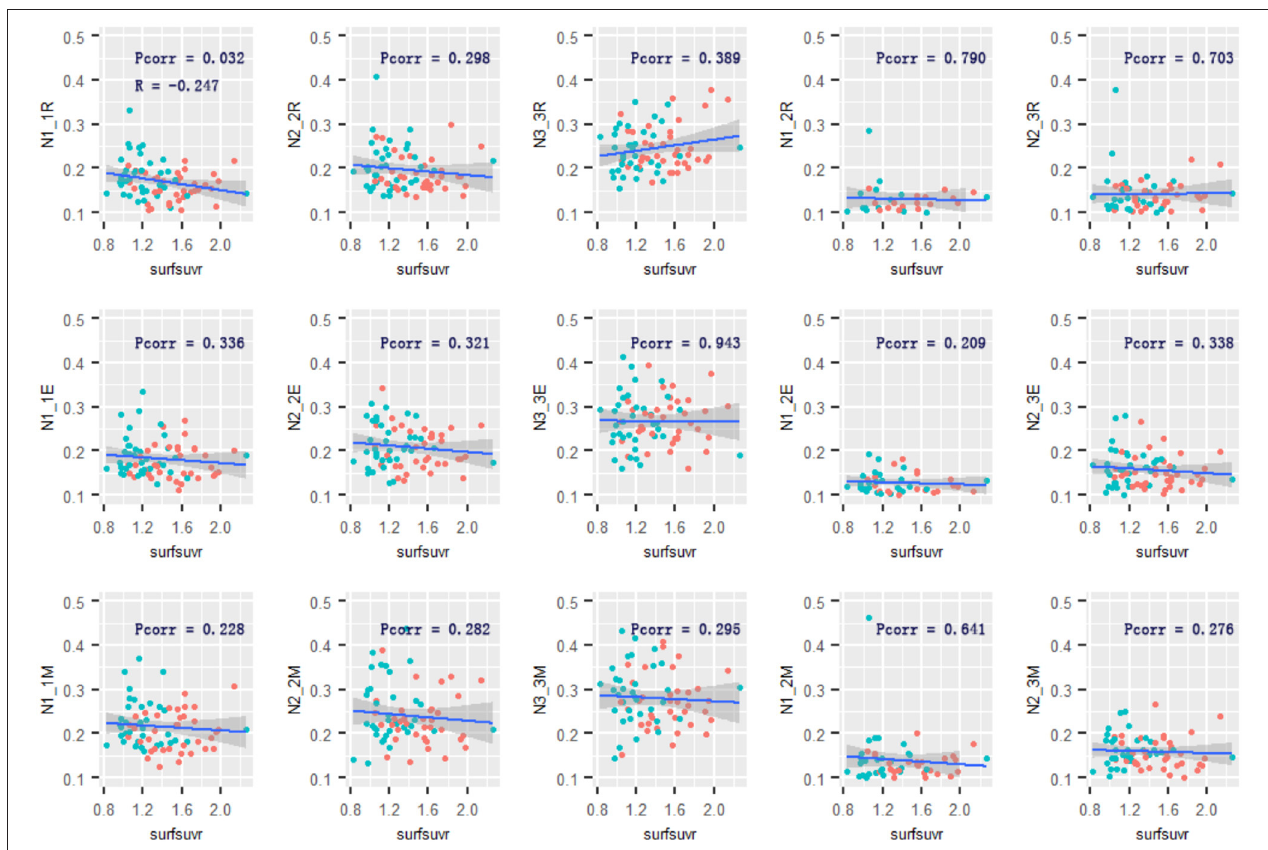
FIGURE 5 | Relationship of cortical A β and Network 1–3 connectivity. The cortical A β deposition was associated with Network 1-Network 1 functional connectivity in the retrieval phase. No other associations were observed. R and Pcorr represented correlation coefficient and significance across two groups. Pcorr in the correlation analysis was corrected by 10,000 permutations. The gray zone around blue lines represent the 95% confidence interval for predictions from the linear model. surfsuvr = surface standardized uptake value ratios; N1_1, Network 1-Network 1; N2_2, Network 2-Network 2; N3_3, Network 3-Network 3; N1_3, Network 1-Network 3; N2_3, Network 2-Network 3; R, Retrieval; E, Encoding; M,